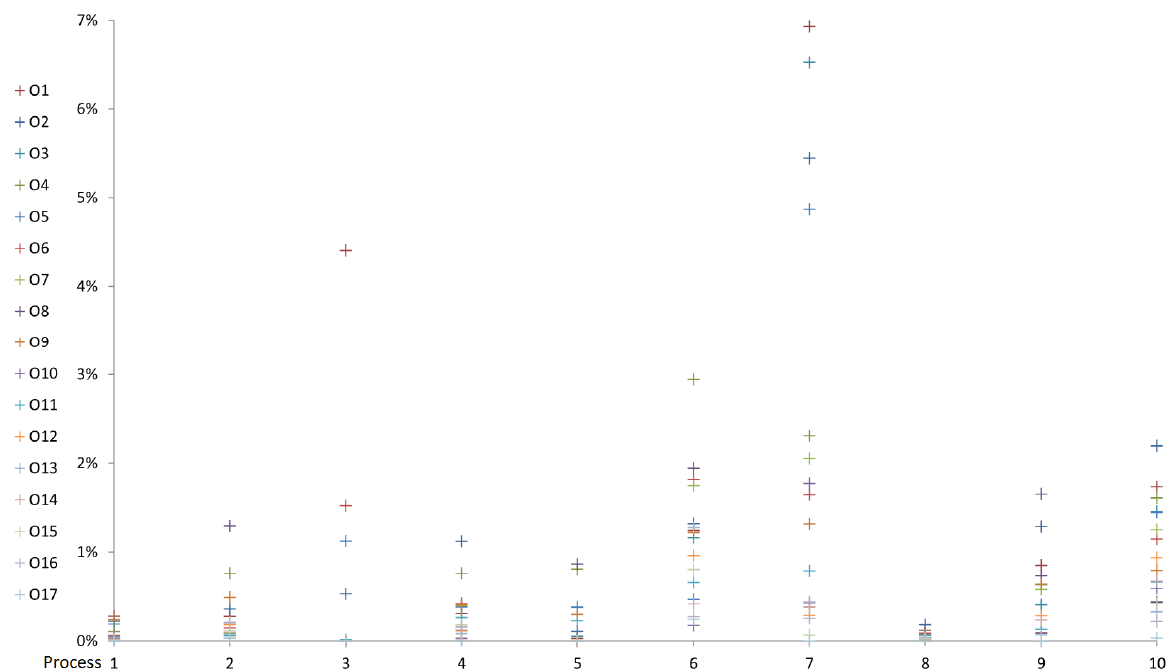
Figure 2. The distribution of the liquidation processes costs of branches of SRK S.A.